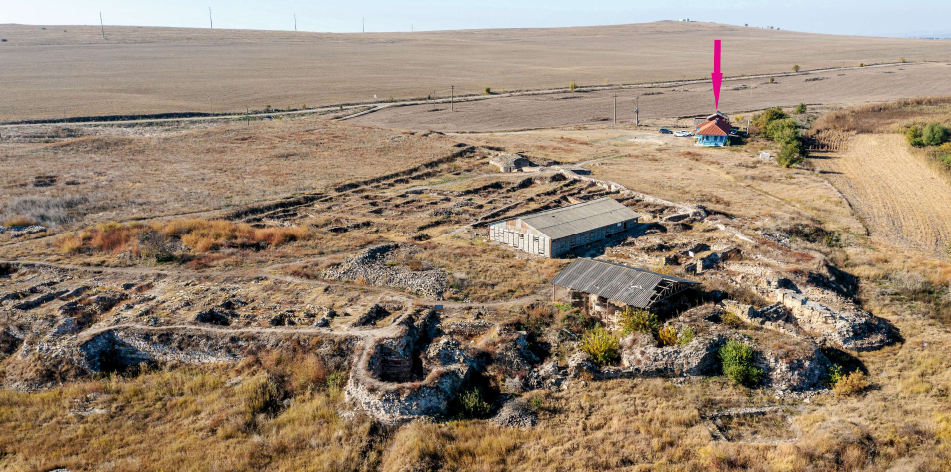
Figure 3. Drone view from east with the extramural area of Halmyris. Magenta arrow indicates the excavation area of 2014 (by Valentin Ștefan, October 2022).